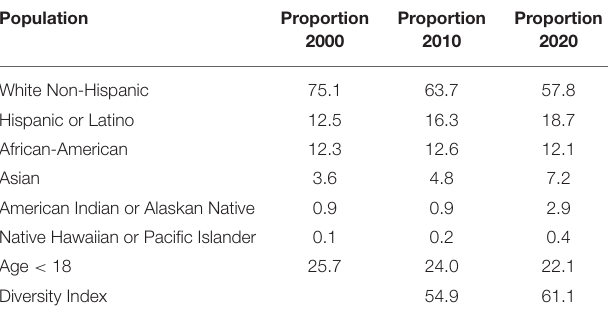
TABLE 1 | Diversity in the United